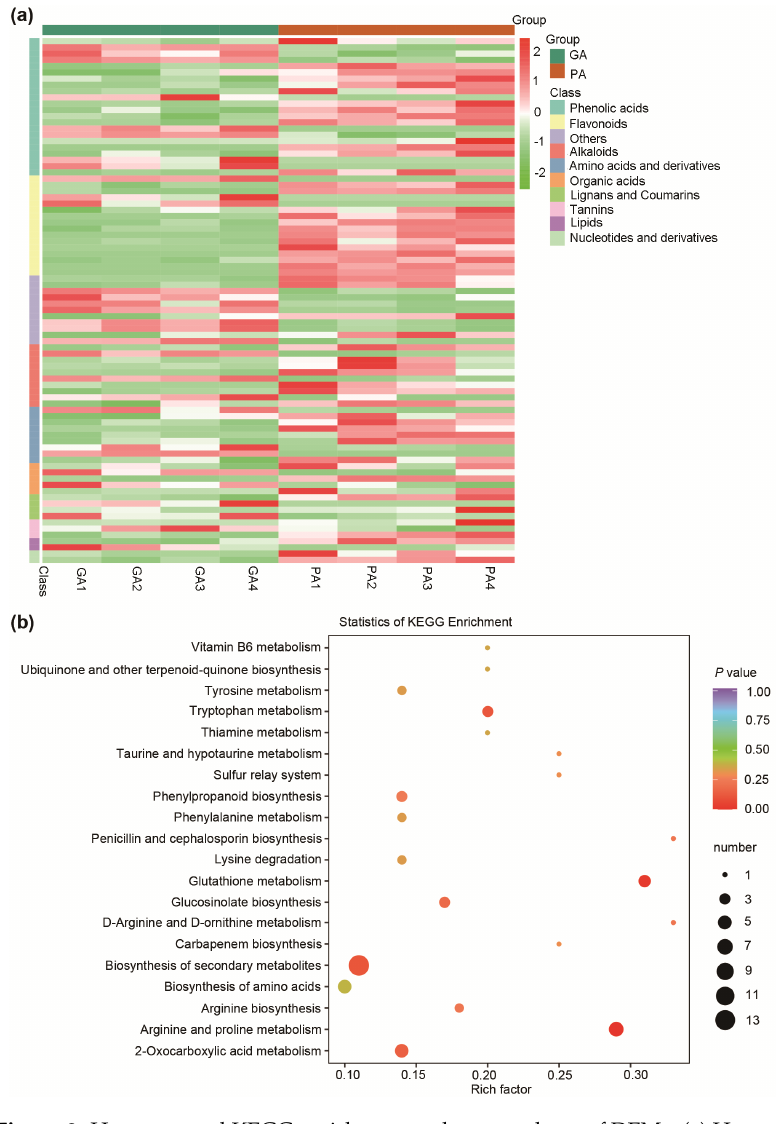
Figure 2. Heat map and KEGG enrichment pathway analyses of DEMs. ( a ) Heatmap diagram of DEMs. Red indicates upregulated metabolites, and green indicates downregulated metabolites. ( b ) Top 30 of KEGG enrichment pathways. Point color indicates p − value. Darker shades of red indicate more significant enrichment. Point size indicates gene numbers. Larger points indicate higher gene number.